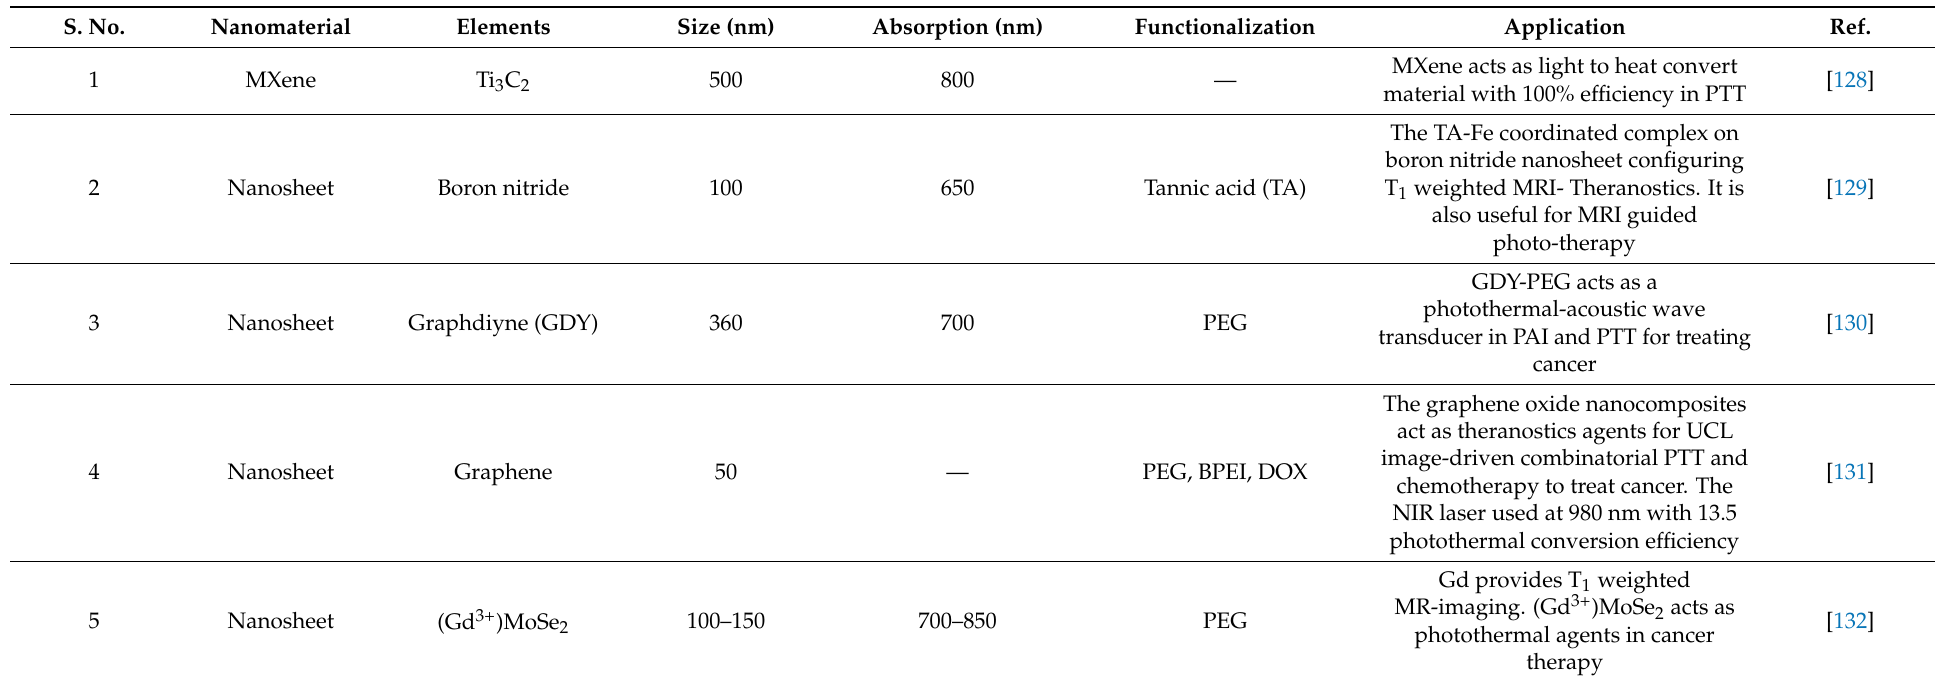
Table 3. Summarizes the list of 2D nanomaterials employed in theranostic